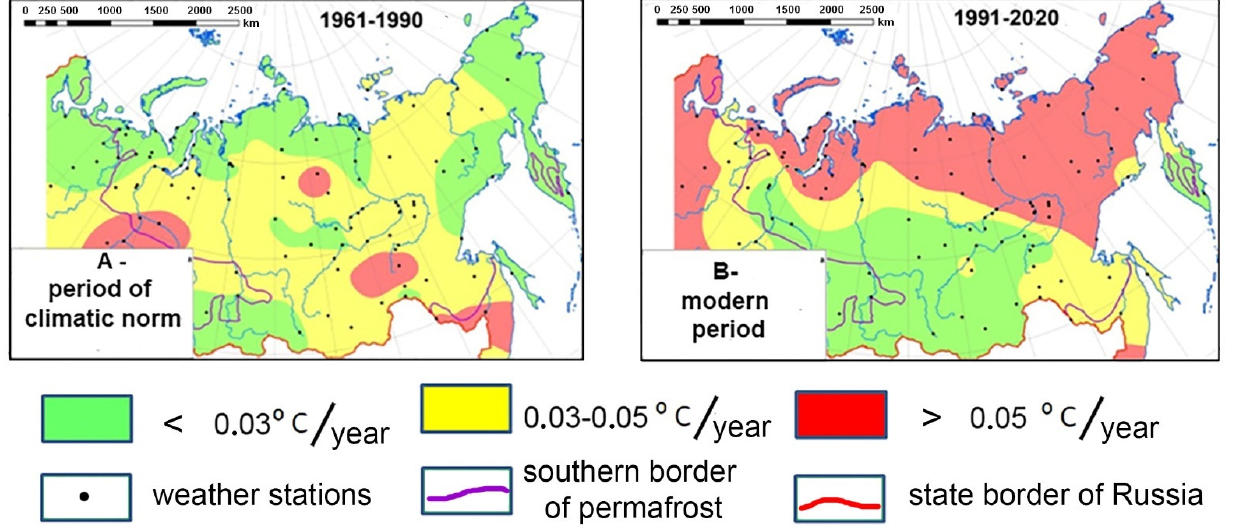
Figure 4. Spatial and temporal changes in the trend of mean annual air temperature in the Russian cryolithozone.